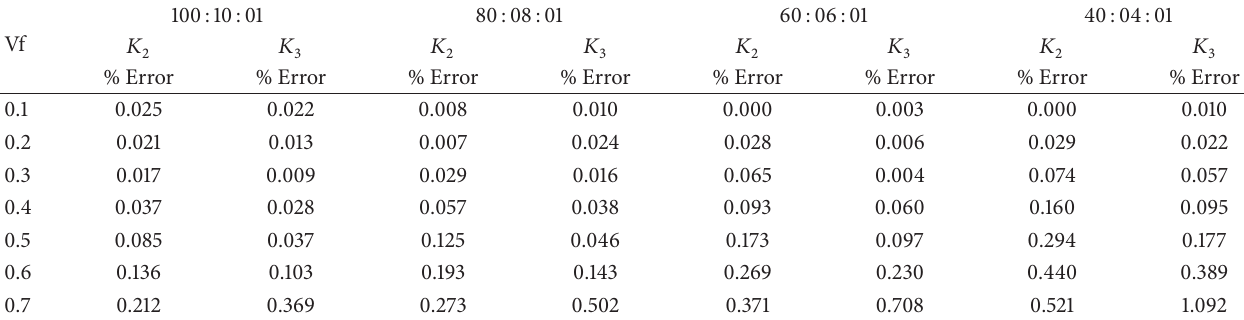
Table 2: % Error between macro- and micromechanics approaches for composite with alternate layers of fibres fully debonded. Vf